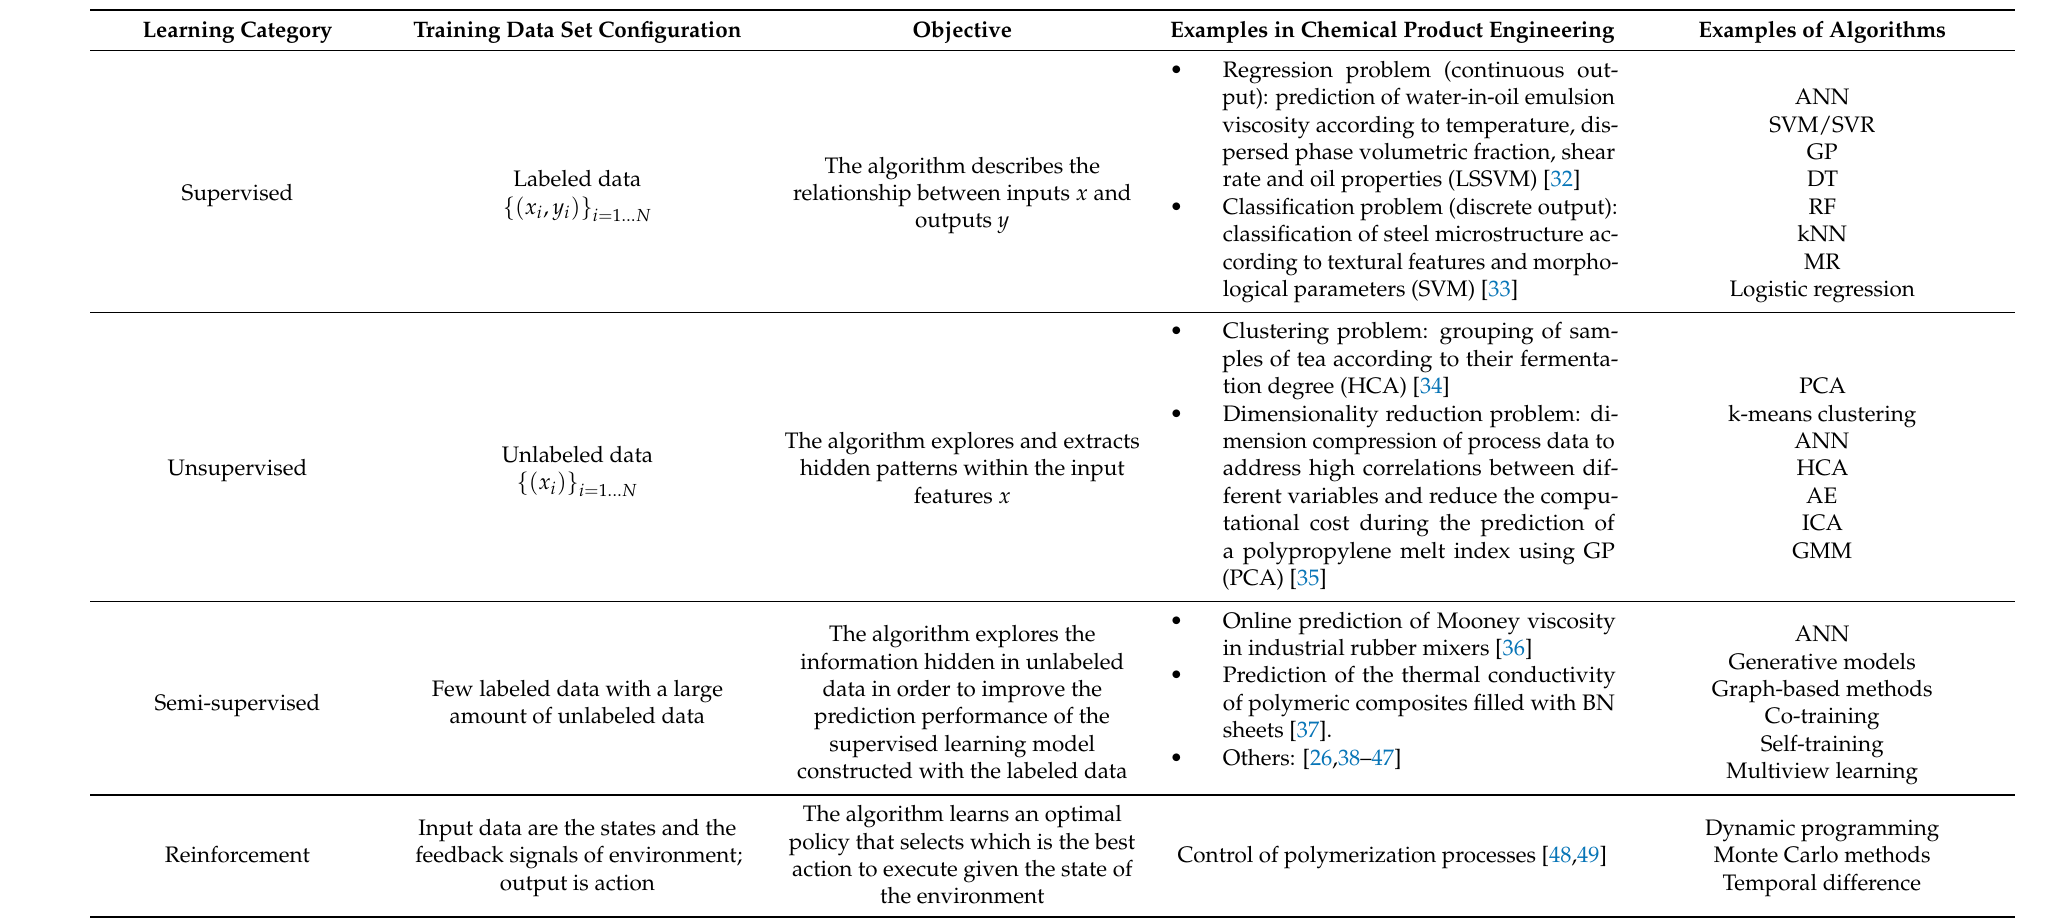
Table 2. Comparison of the different ML